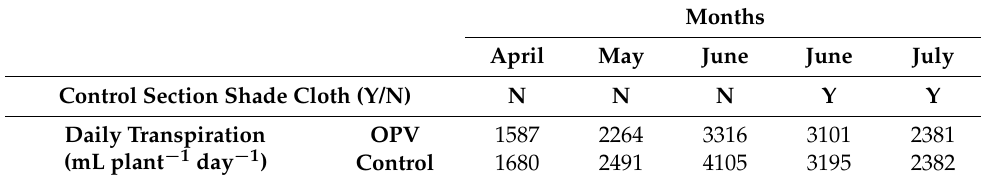
Table 2. Average monthly values for daily plant transpiration (mL plant − 1 day − 1 ) in OPV and Control